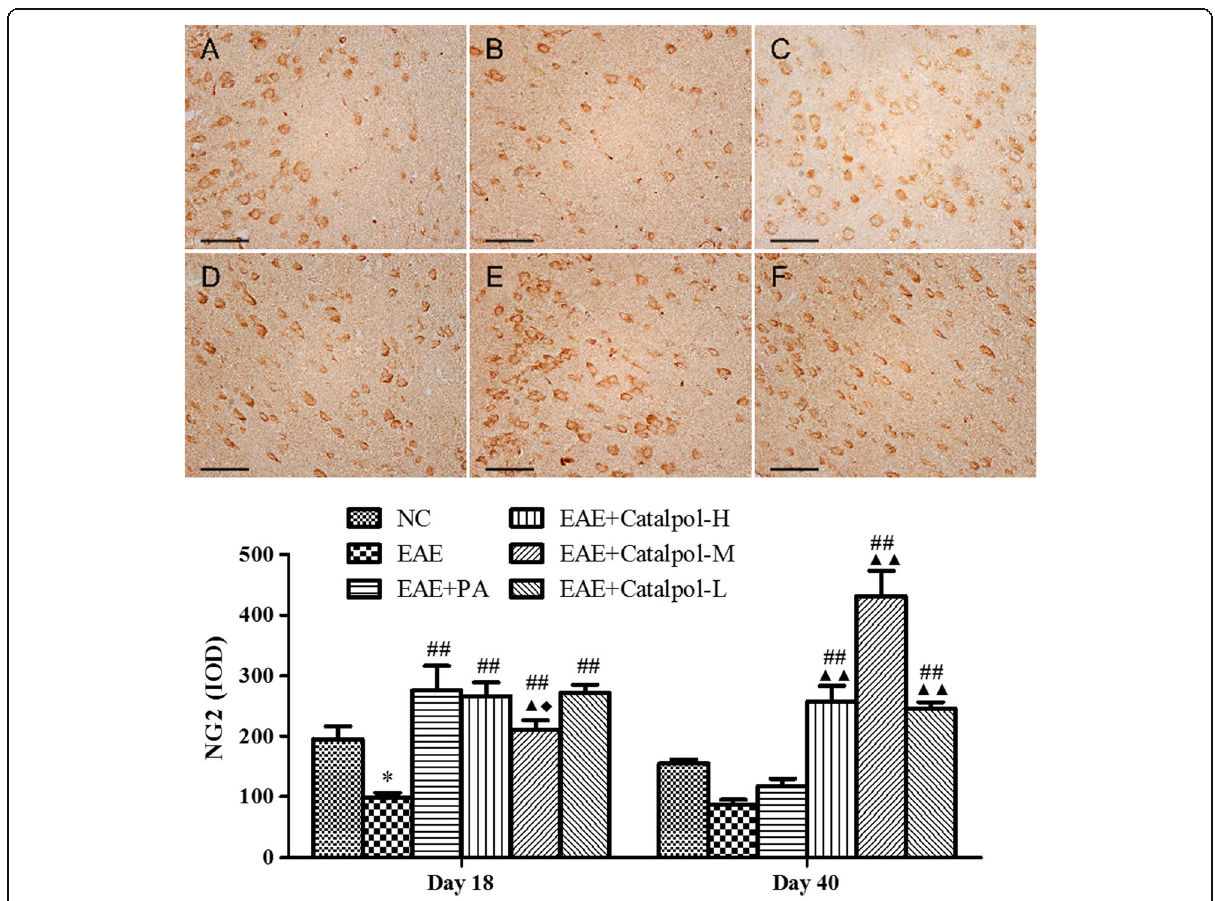
Fig. 6 The protein expressions of NG2 in the brains of mice on Day 18 and Day 40. a to f show NG2 expressions in the cortex of mice on Day 40 in NC ( n =4), EAE ( n =4), EAE+ PA ( n =4), EAE+Catalpol – H ( n =4), M ( n =4) and L ( n =4) mice, respectively (scale bar 20 μ m). The protein expressions of NG2 in the cortex of mice were analyzed. Note: * P <0.05 vs. NC; ## P <0.01 vs. EAE; ◆ P <0.05 vs. EAE+PA; ▲ P <0.05, ▲▲ P <0.01 vs. EAE+Catalpol – H